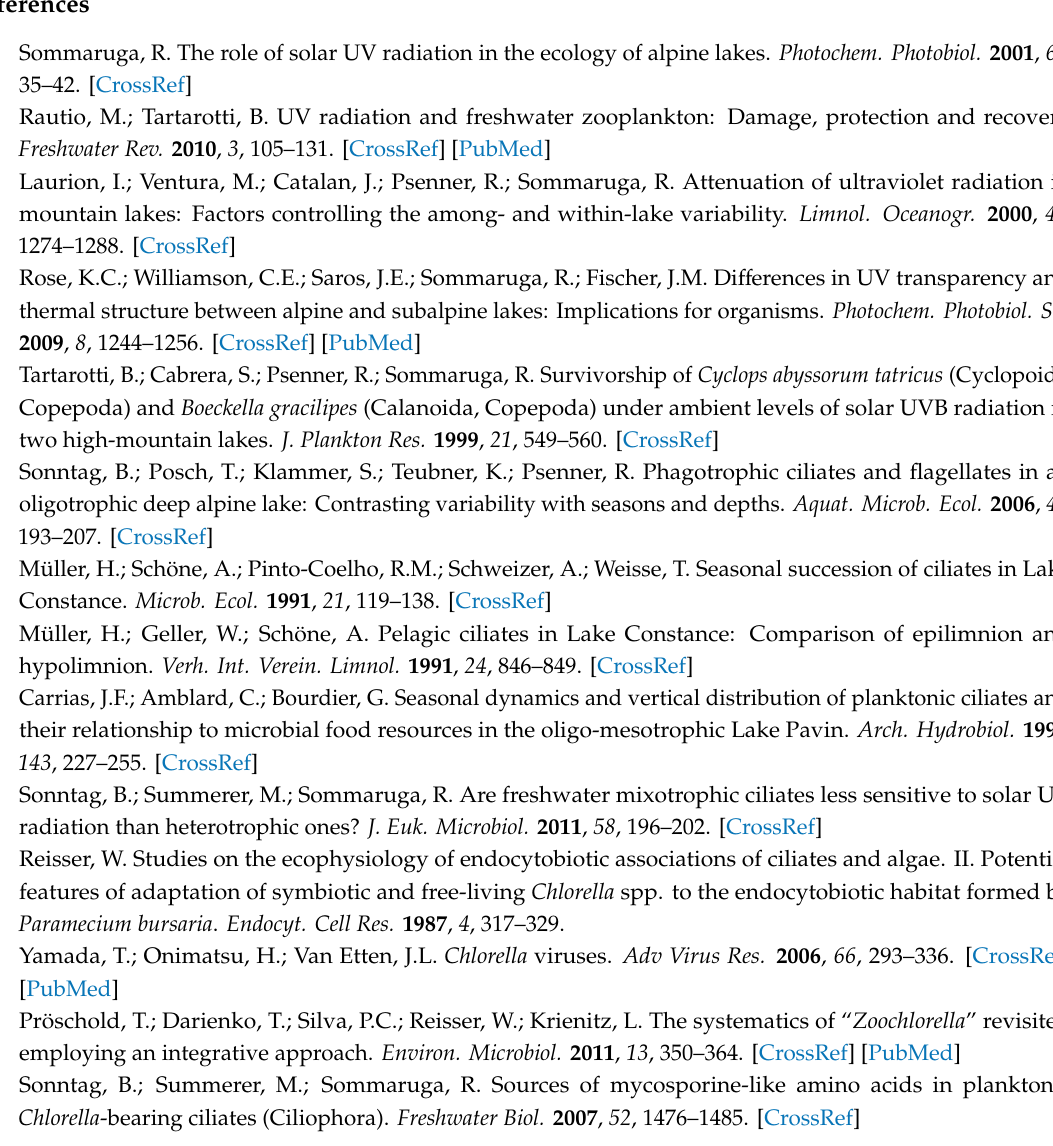
Table S1: UV-A and UV-B doses (kJ m − 2 ) over the experimental period, Figure S1: Scheme of the morphological changes of Pelagodileptus trachelioides observed under irradiation conditions in the photoenzymatic repair experiment, Figure S2: Seasonal and spatial occurrence of Pelagodileptus trachelioides , Vorticella chlorellata , and Stokesia vernalis in Piburgersee in 2004–2005